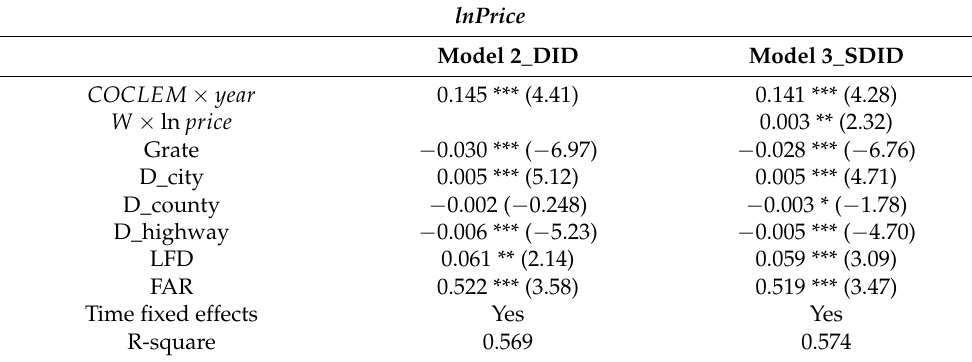
Table 5. Estimations of the effect of COCLEM on the SIL transaction price.